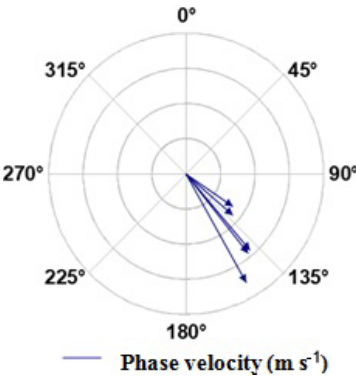
Figure 2. Compass graph showing wave velocities and the direction of propagation – each circle denotes a velocity of 20ms − 1